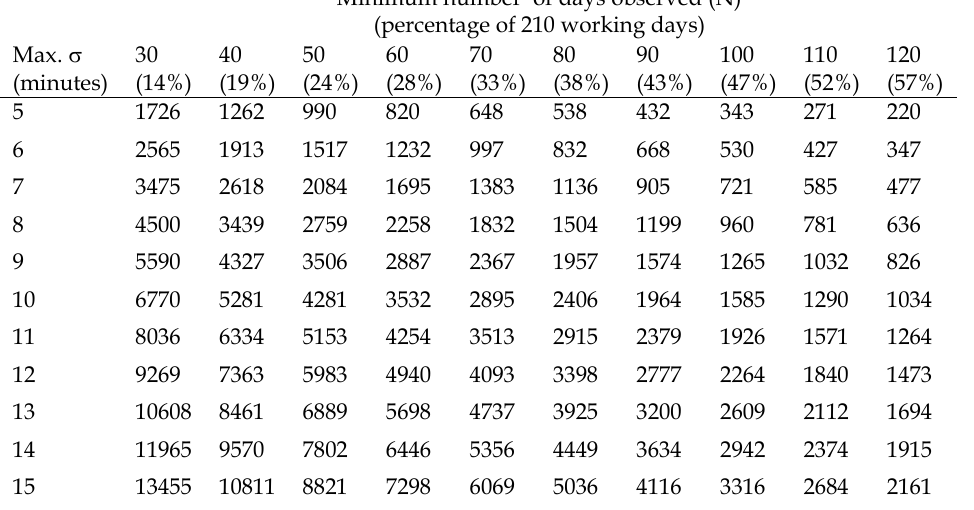
Table 1. Numbers of vehicles across sites meeting minimum days observed and maximum standard deviation of arrival time